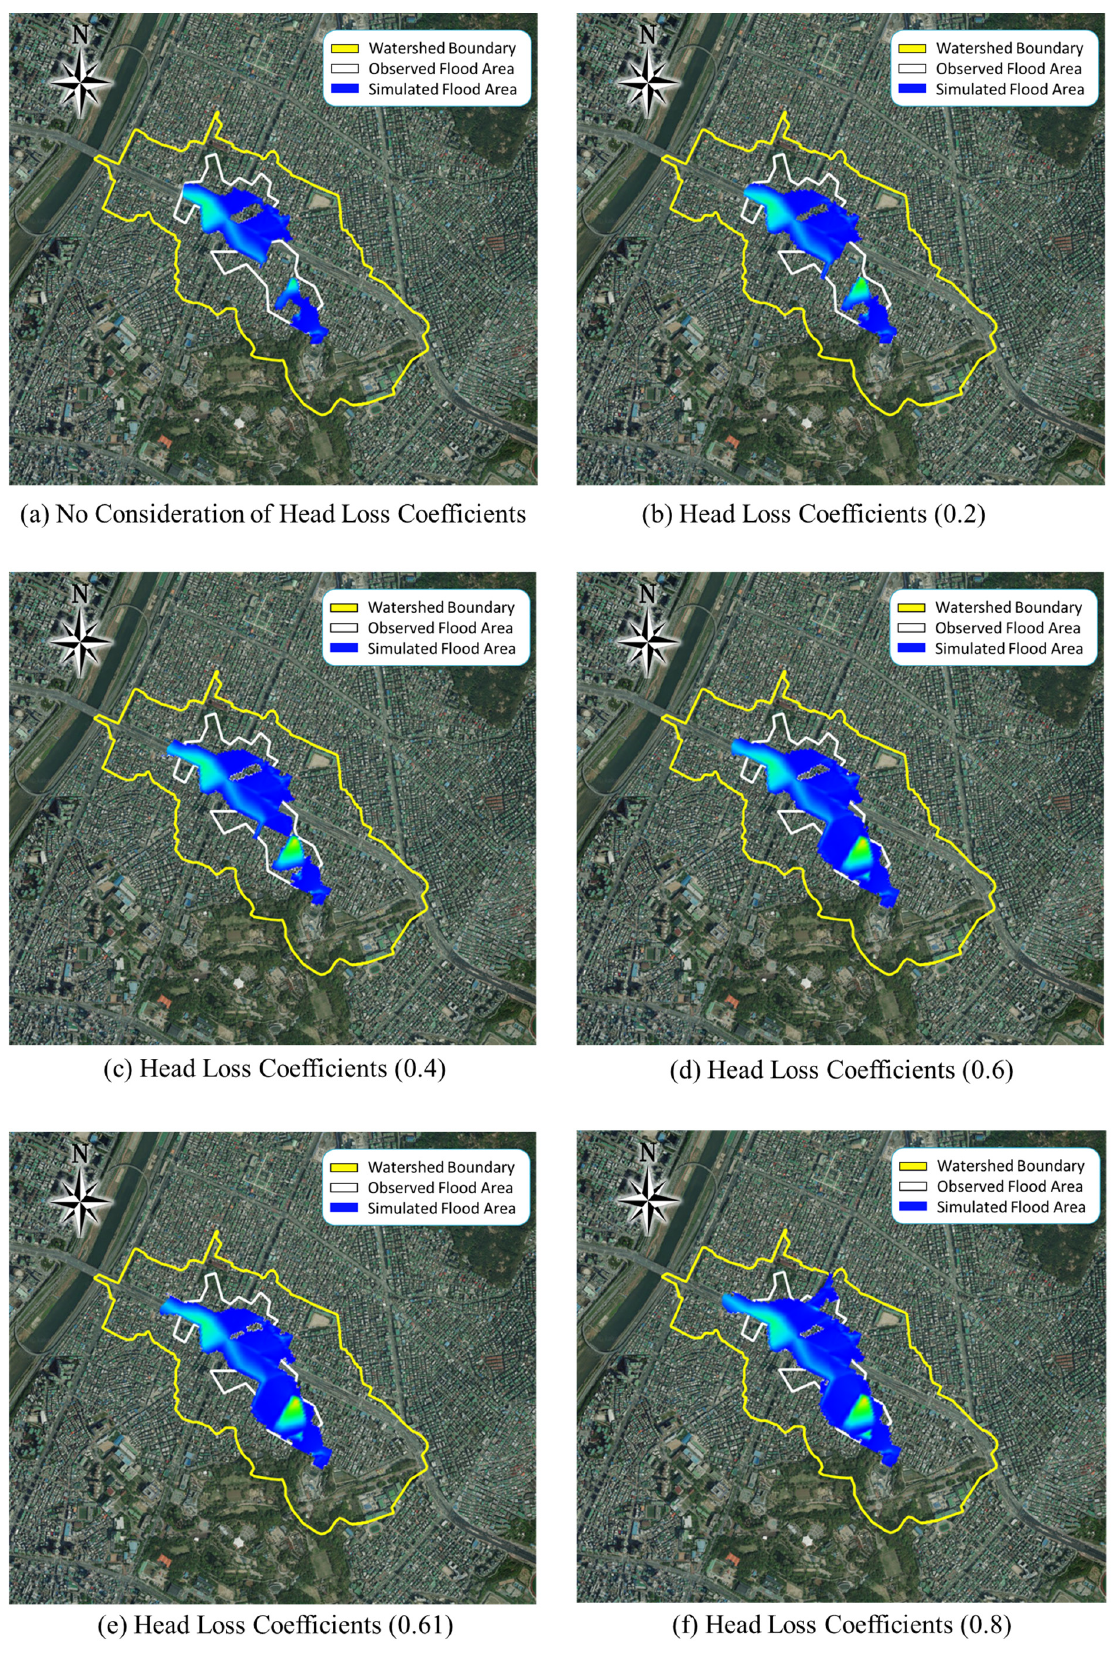
Figure 15. Comparison of the observed and simulated inundation area (Gunja watershed).